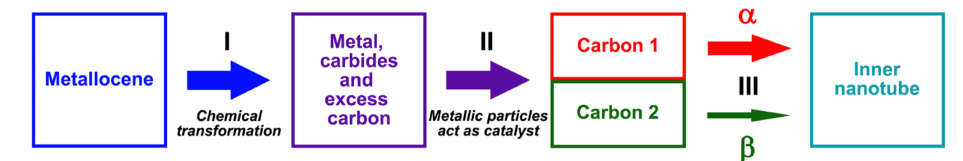
Figure 11. The illustration of the growth model of inner tubes from metallocene molecules en- capsulated inside SWCNTs. The thermal treatment of the filled SWCNTs leads to the chemical transformation of metallocene to metal, metal carbides and excess carbon (step I). Metallic nanoparti- cles act as a catalyst and transform carbon to inner tubes (step II). The part of excess carbon (1) is processed rapidly at the beginning and forms the inner tube at a rate α . The other part of carbon (2) is transformed slower into the inner tube at a lower rate β (step